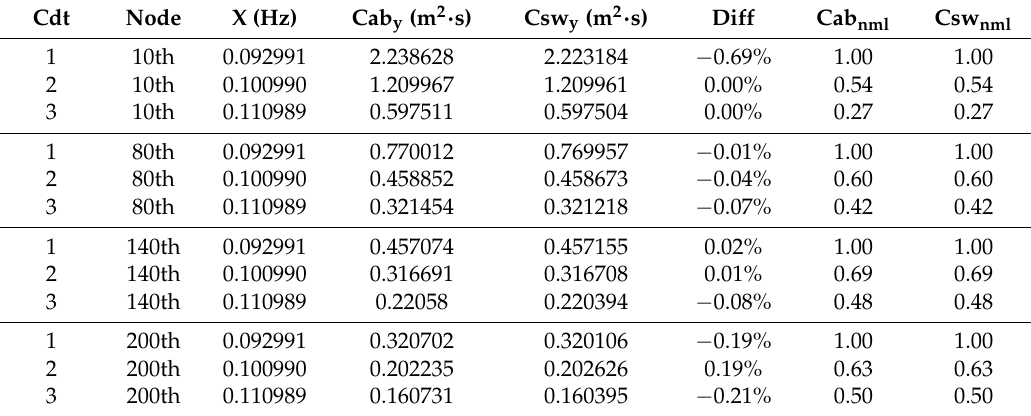
Table 15. Difference and normalized values of spectrum.